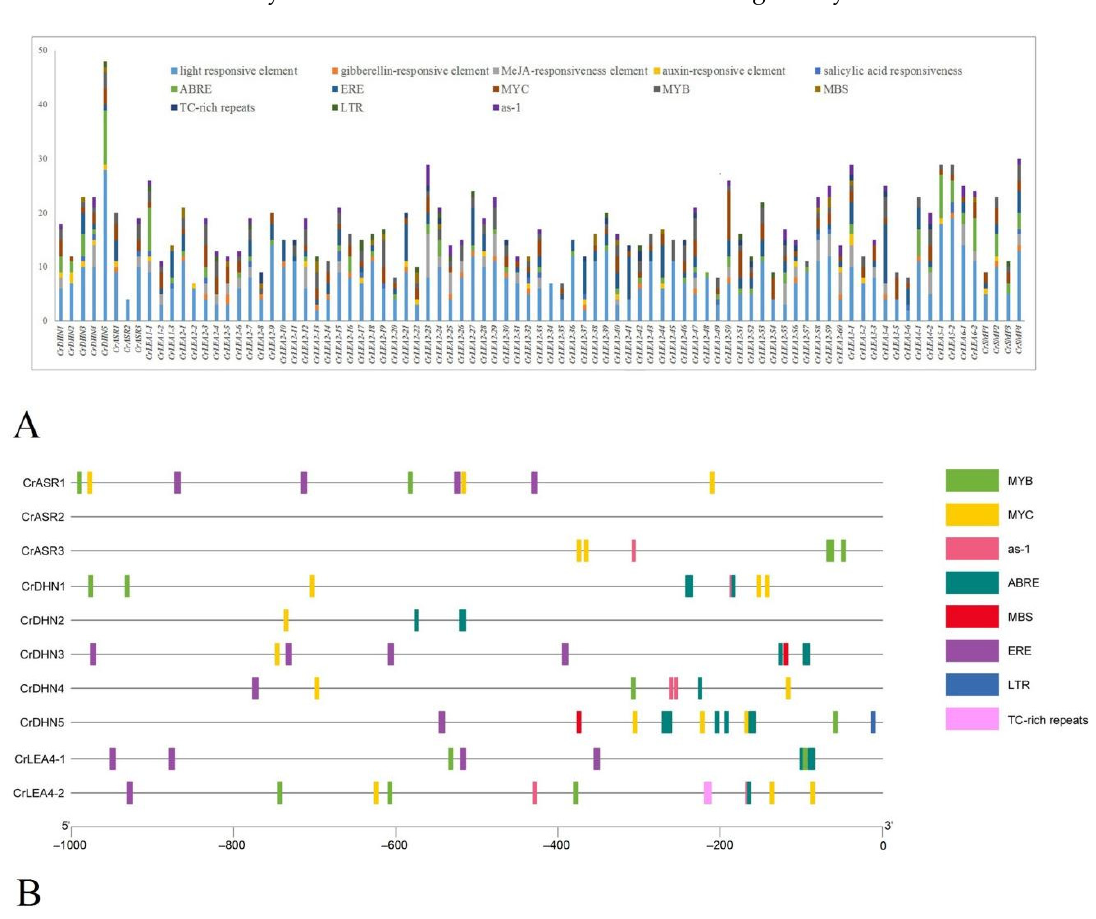
Figure 5. Prediction of cis -regulatory elements in the 1000-bp upstream regulatory regions of CrLEA/CrASR genes. ( A ) Summaries of the twelve cis -regulatory elements in the 87 CrLEA/CrASR promoter regions. ( B ) Distribution of the eight cis -regulatory elements (MYB, MYC, as-1, ABRE, MBS, ERE, LTR, and TC-rich repeat) in the 10 CrLEA/CrASR genes promoter regions. The scale bar represents 200 bp.